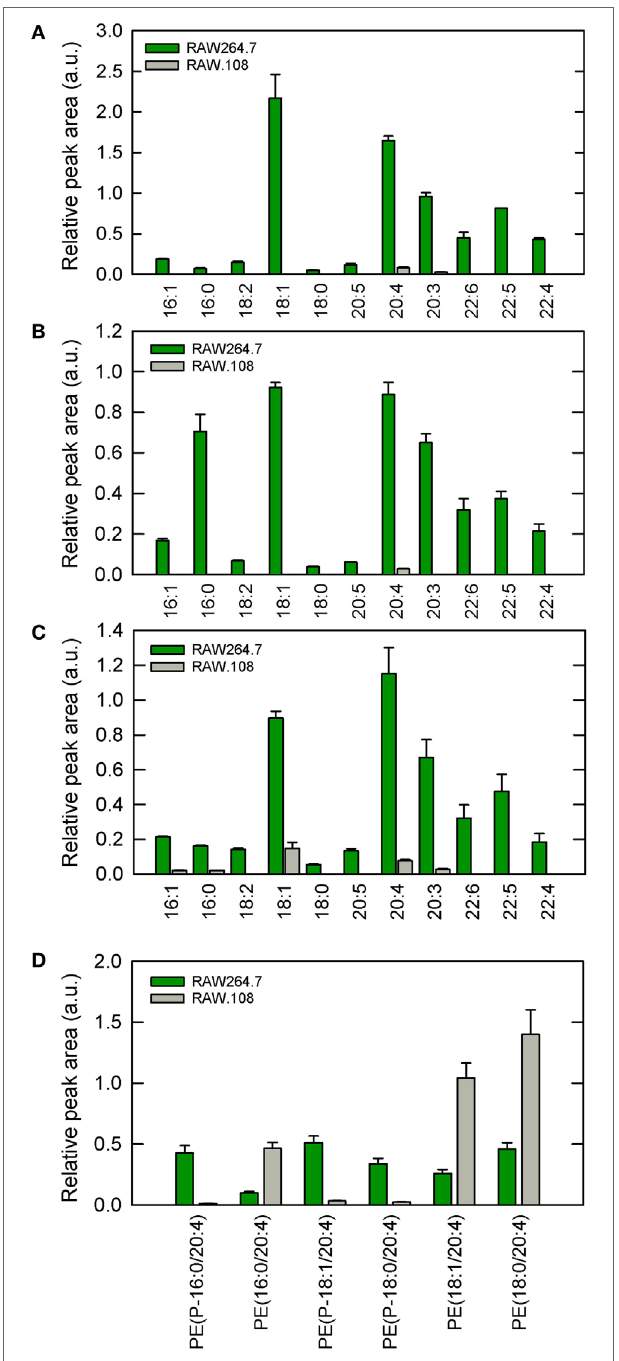
FigUre 2 | Ethanolamine plasmalogen content of RAW 264.7 and RAW.108 cells. Analyses were carried out by liquid chromatography coupled to mass spectrometry. The fatty acid distribution within plasmalogen species containing hexadecyl (P-16:0) (a) , octadecenyl (P-18:1) (B) , or octadecyl (P-18:0) (c) moieties at sn-1 position is shown. Fatty acids (abscissa) are abbreviated as carbon number:double bonds. In (D) , the distribution of arachidonic acid (20:4) moieties in ethanolamine phospholipids (including plasmalogen and diacyl species) in RAW 264.7 cells versus RAW.108 cells is shown. Results are given as mean ± SEM of three independent experiments carried out in duplicate.